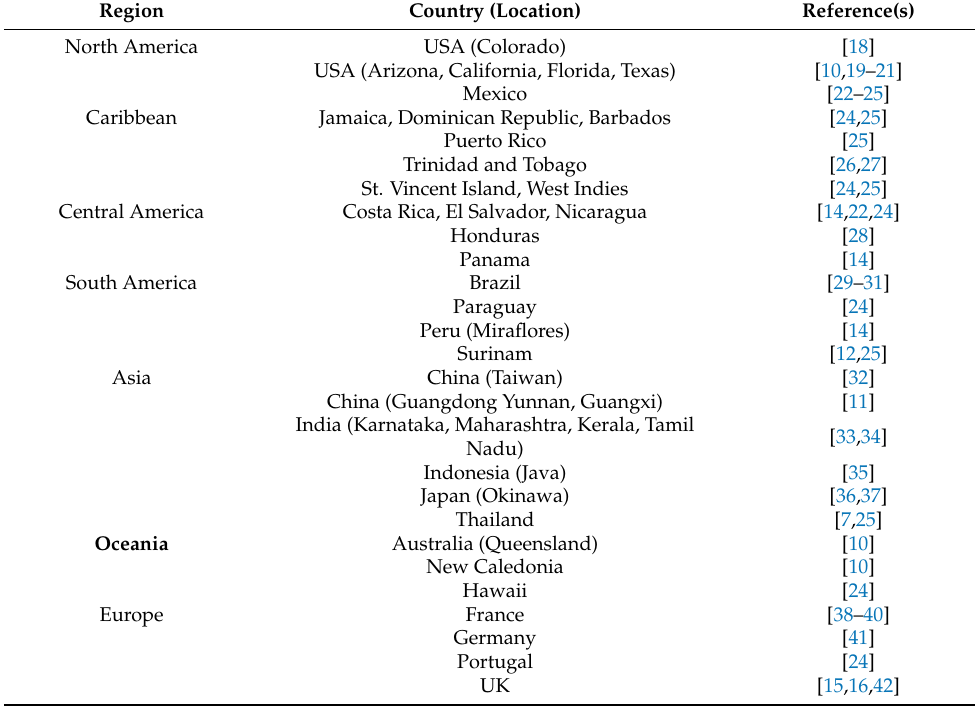
Table 1. The distribution of Franklinothrips vespiformis